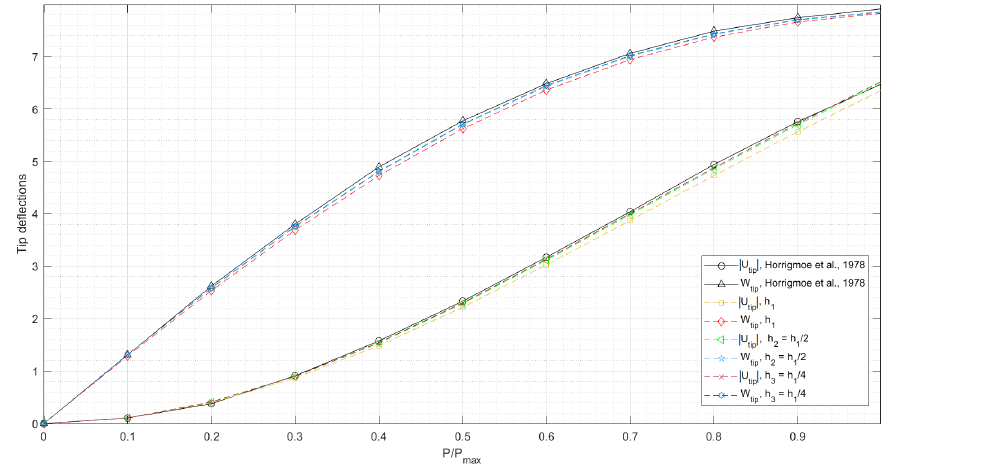
Figure 4. Load–deflection curves for the cantilever subjected to end shear force (non-conservative loading). U tip and W tip are the vertical and horizontal tip deflections. The values of U tip are negative.